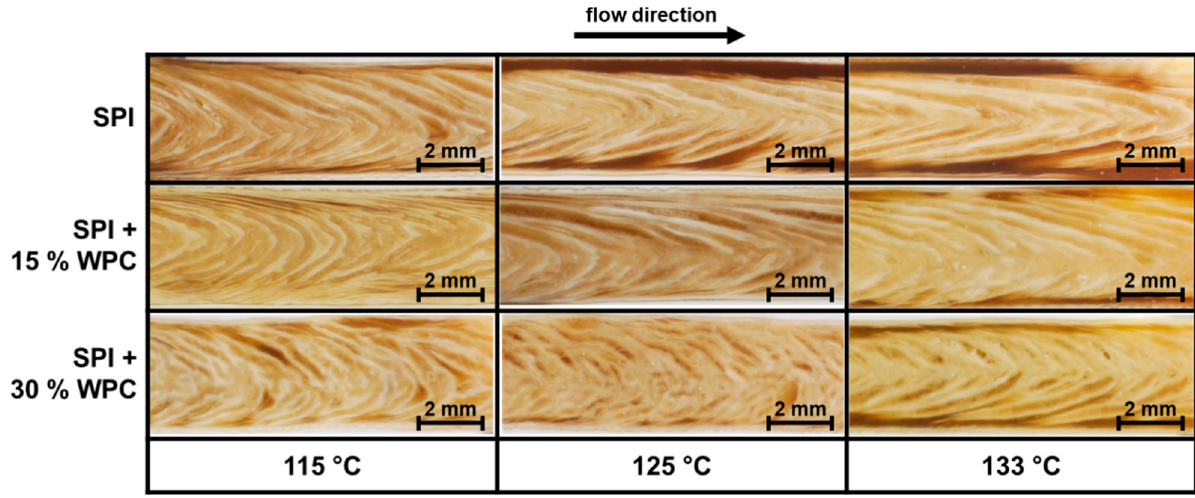
Figure 6. Multi-phase morphology, obtained through cryo-imaging of extrudates for different protein blends (0–30% WPC) and material temperatures (115–133 °C).